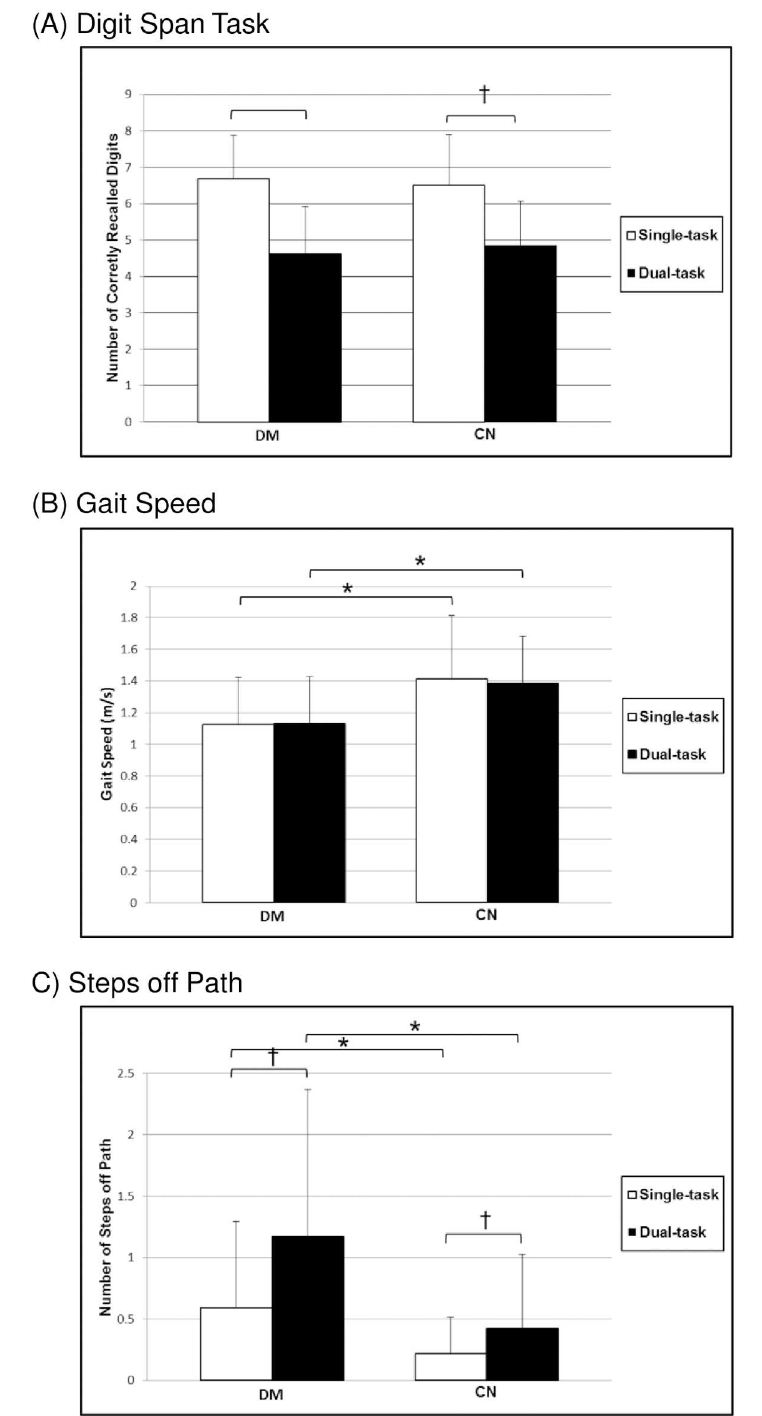
Fig 2. Walking and Remembering task performance. (A) Average number of digits recalled,(B) gait speed, and (C) numberof steps off path under single-task (white bars) and dual-task(black bars) conditions on the Walkingand Remembering Test. Error bars reflect standard deviationfrom the mean. Within-group differences in height betweensingle- and dual-task bars reflect the changesin task performance (e.g. dual- task costs) for each task. * Significantbetween-group difference at p < 0.05.† Significantwithin-group difference at p < 0.05.